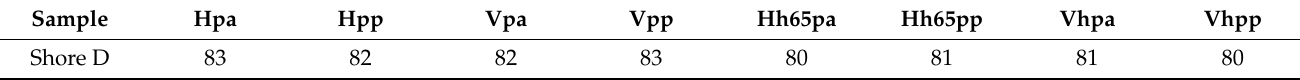
Table 3. The Shore D test results of the printed and the heat-treated (h65) vertically printed (V) and horizontally printed (H) specimens’ parallel (pa) and perpendicular (pp)